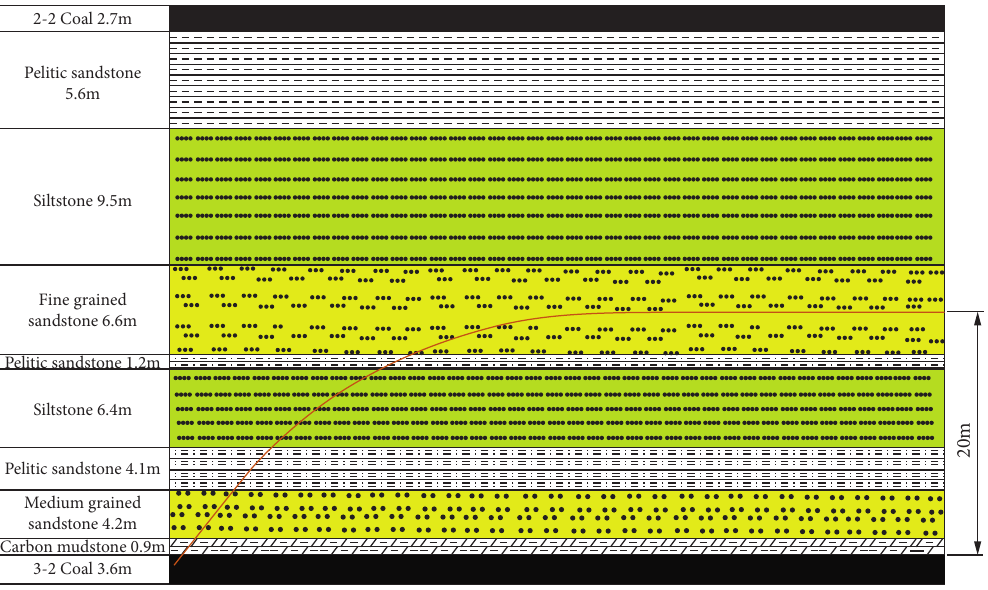
Figure 18: Profile of the directional long borehole.